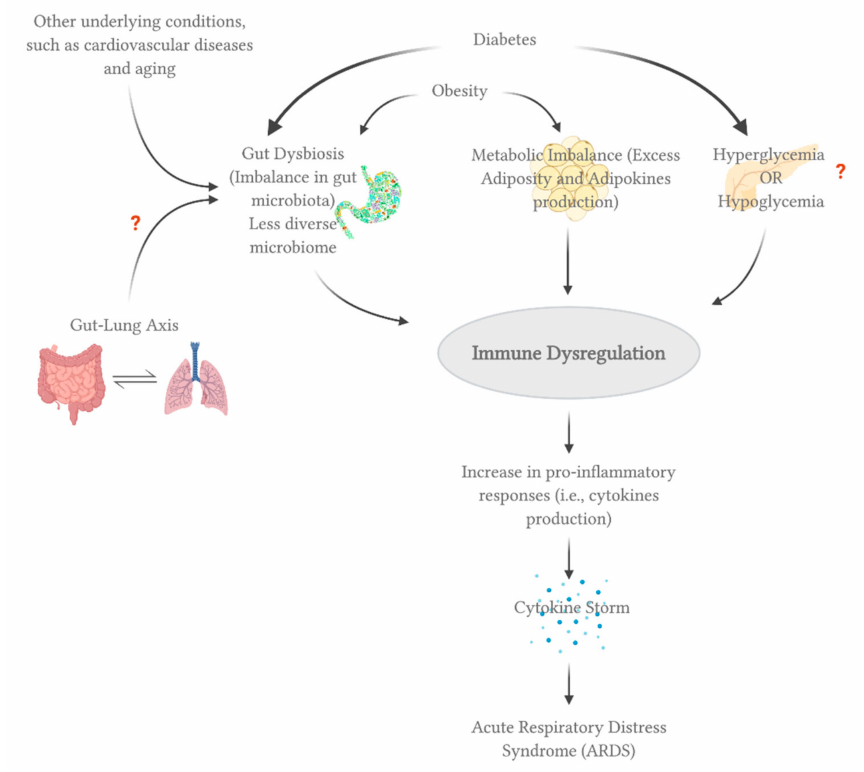
Figure 3. Factors affecting the clinical severity of COVID-19. All of the figures were created with BioRender.com.